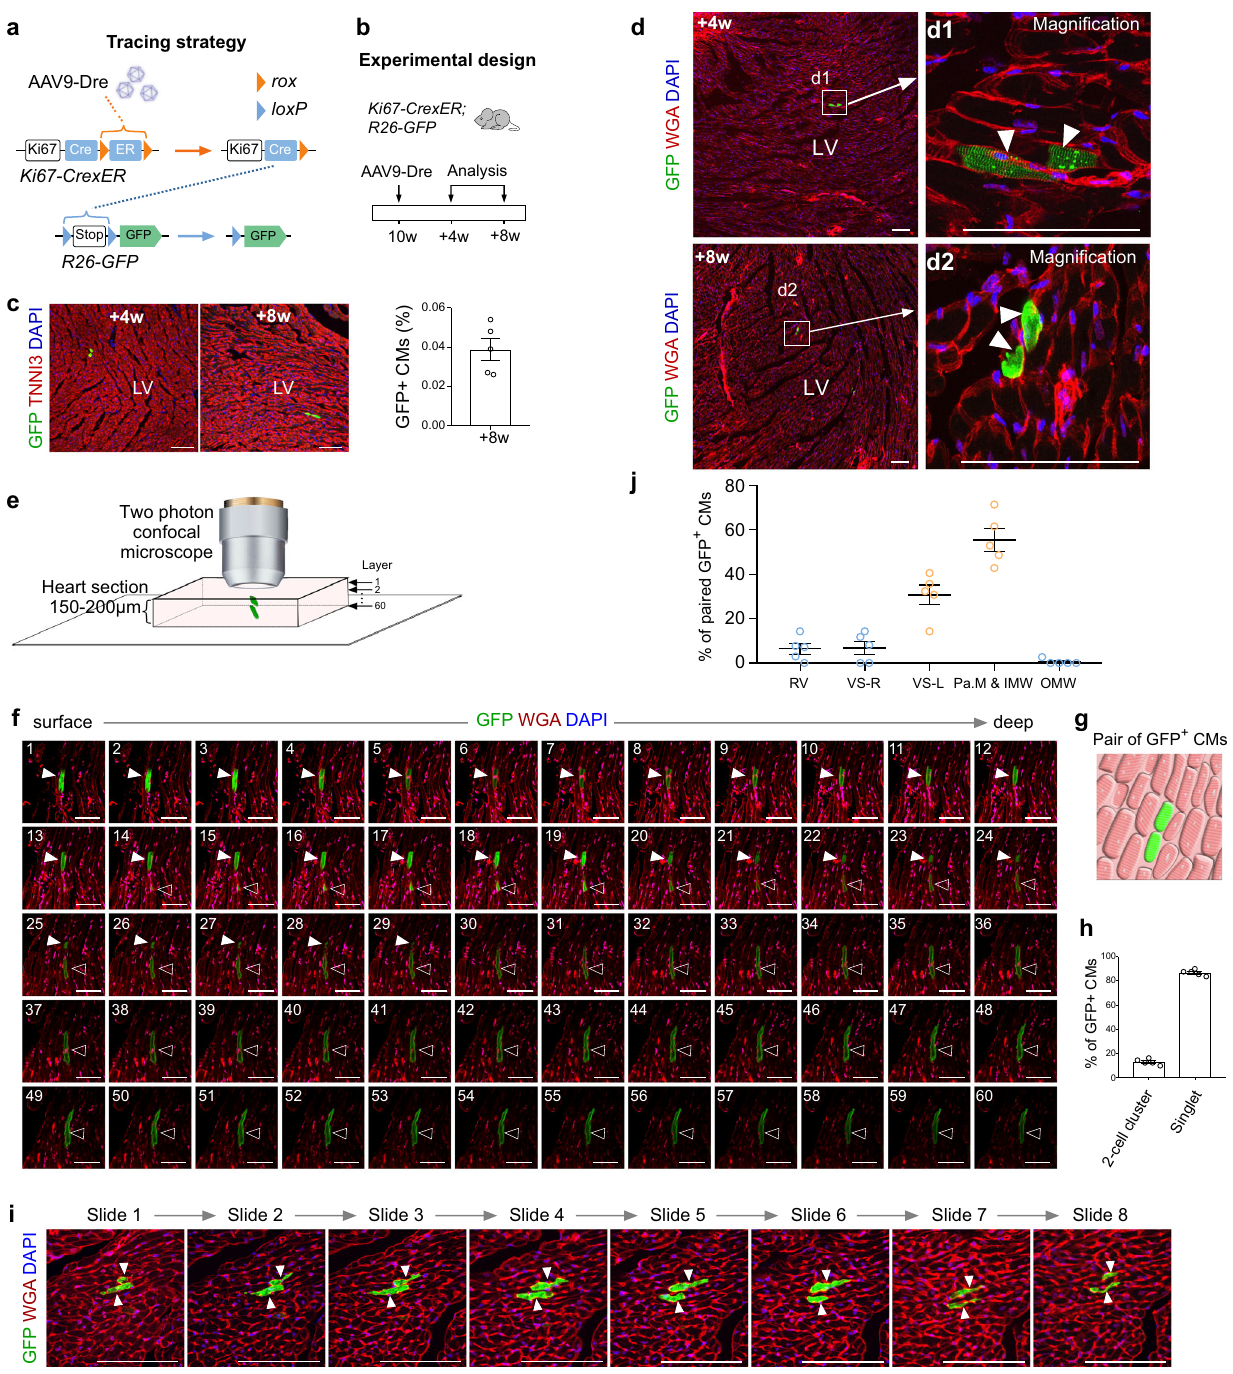
Fig. 3 A subset of Ki67 + cardiomyocytes labeled by ProTracer have undergone cytokinesis. a Schematic showing strategy of labeling Ki67 + cardiomyocytes by AAV9-Dre injection into Ki67-CrexER ; R26-GFP mice. b Schematic showing the experimental design. A low dosage of AAV9-Dre was injected into mice. c Immunostaining for GFP and TNNI3 on heart sections reveals sparse labeling of cardiomyocytes (CMs) and quanti fi cation of the percentage of CMs expressing GFP. d Immunostaining for GFP and WGA on 10 µ m heart sections reveals sparsely labeled CMs (< 0.1%) on heart sections collected at 4 or 8 weeks after AAV injection. Arrowheads, sparse pair of GFP + CMs. e , f Confocal microscopy of thick heart sections (150 – 200 µ m) reveals two neighboring GFP + CMs (arrowheads). Each stacked image is composed of ~ 60 layers of scanned signals of heart sections stained with GFP and WGA. g Cartoon image showing a pair of two neighboring GFP + CMs. h Quanti fi cation of the percentage of GFP + CMs contributed from 2-cell cluster or single-cell cluster (singlet). Data are the mean ± SEM; n = 5. i Immunosta i ning for GFP and WGA on consecutive tissue sections (serial tissue slide 1 to slide 8, each 10 µ m) revealed a pair of neighboring CMs (arrowheads). j Quanti fi cation of the distribution of GFP + 2-cell clusters in different regions of the ventricles. Data are the mean ± s.e.m.; n = 5. Scale bars: 100 µ m. Each image is representative of fi ve individual biological